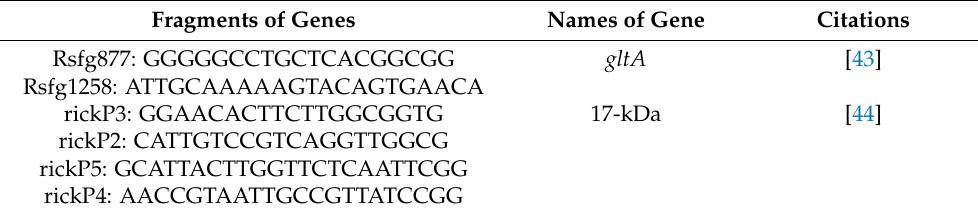
Table 2. Primers used for the detection of Rickettsiales DNA in